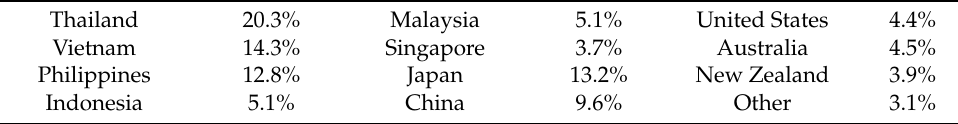
Table 2. Overseas golf travel destinations